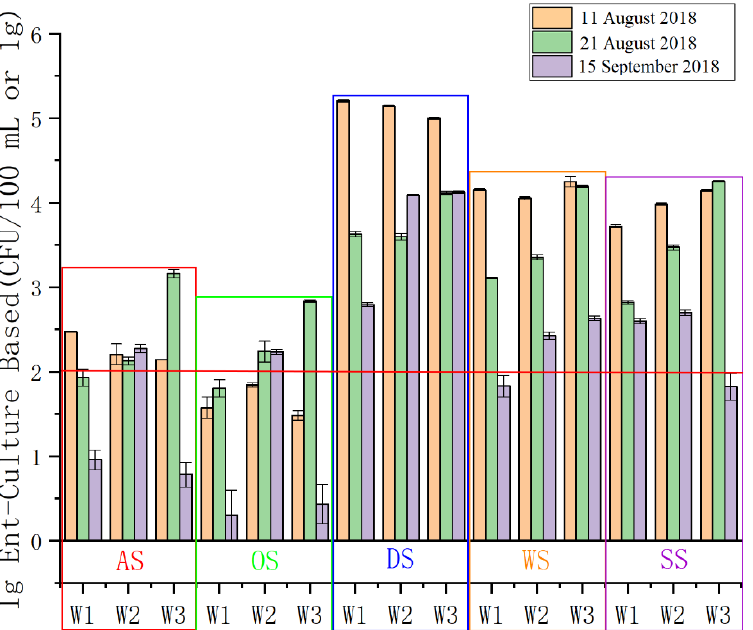
Figure 2. The concentration distribution of enterococci during the typhoon event, in which DS represents dry sand; WS represents wet sand; SS represents submerged sand; AS represents alongshore seawater; OS represents offshore seawater.